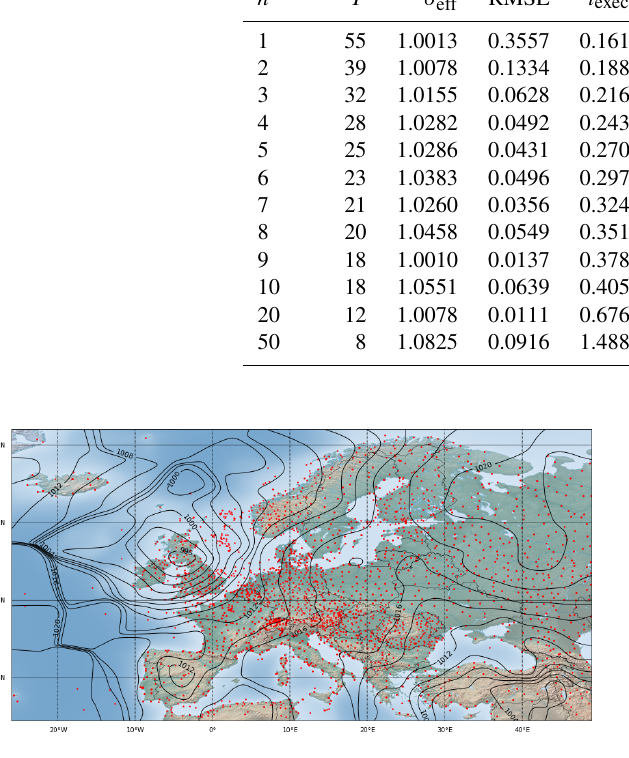
Figure 10. Exact Barnes interpolation with the naive algorithm for the same setup as for Fig. 3 but using spherical distances from S 2 instead of Euclidean distances from R 2 . The generated isolines are notably different in the northern part, while they are quite similar in the south.